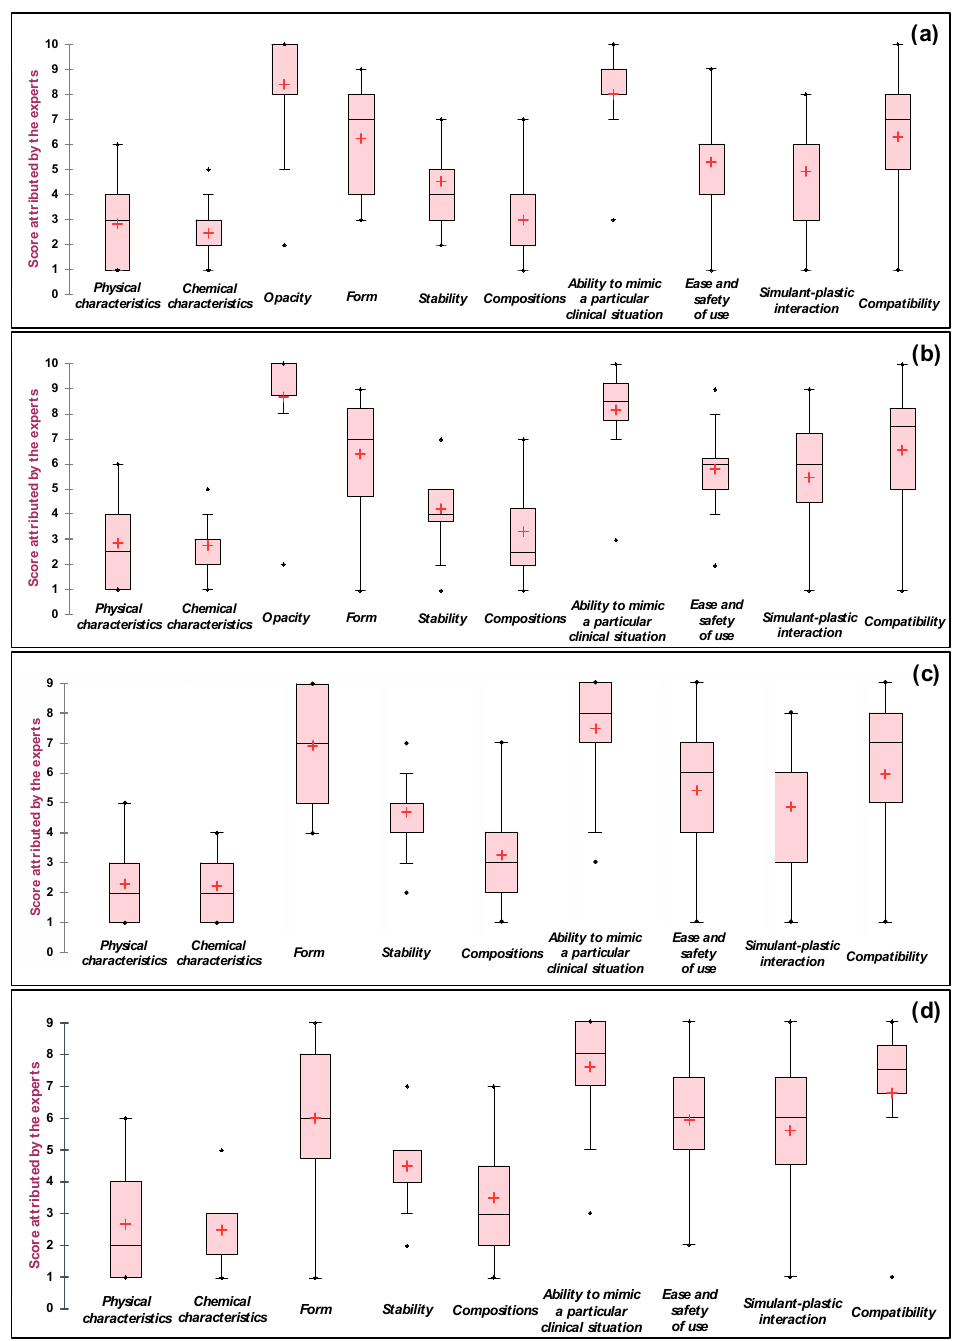
Figure 2. Box plots of the scores obtained for each criterion related to each labile blood product, as attributed by the members of the nominal group. ( a ) Whole blood, ( b ) red blood cell concentrate, ( c ) plasma, and ( d ) platelet concentrate. +: mean value; ◆ : outlier value.